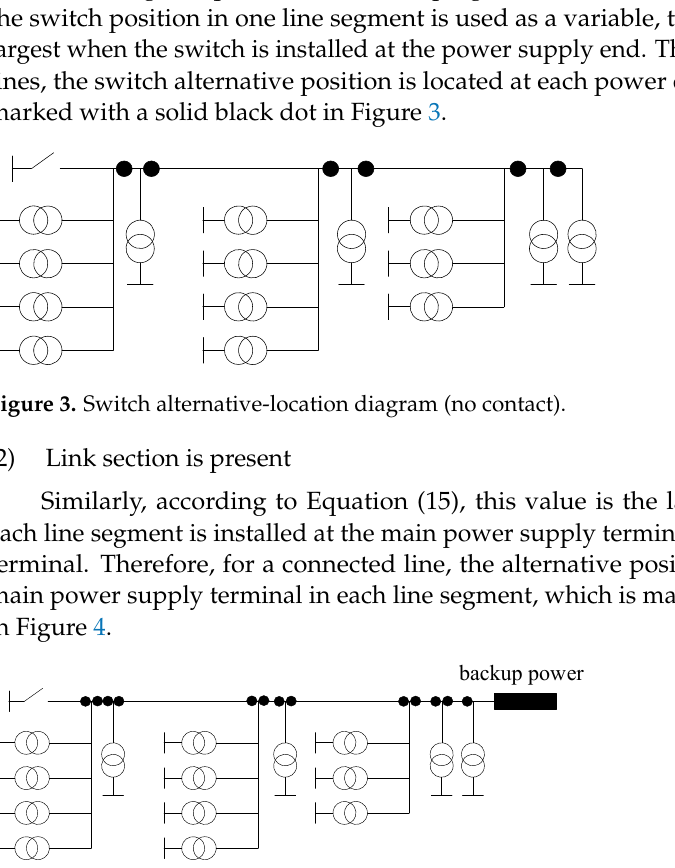
Figure 4. Switch alternative-location diagram (with